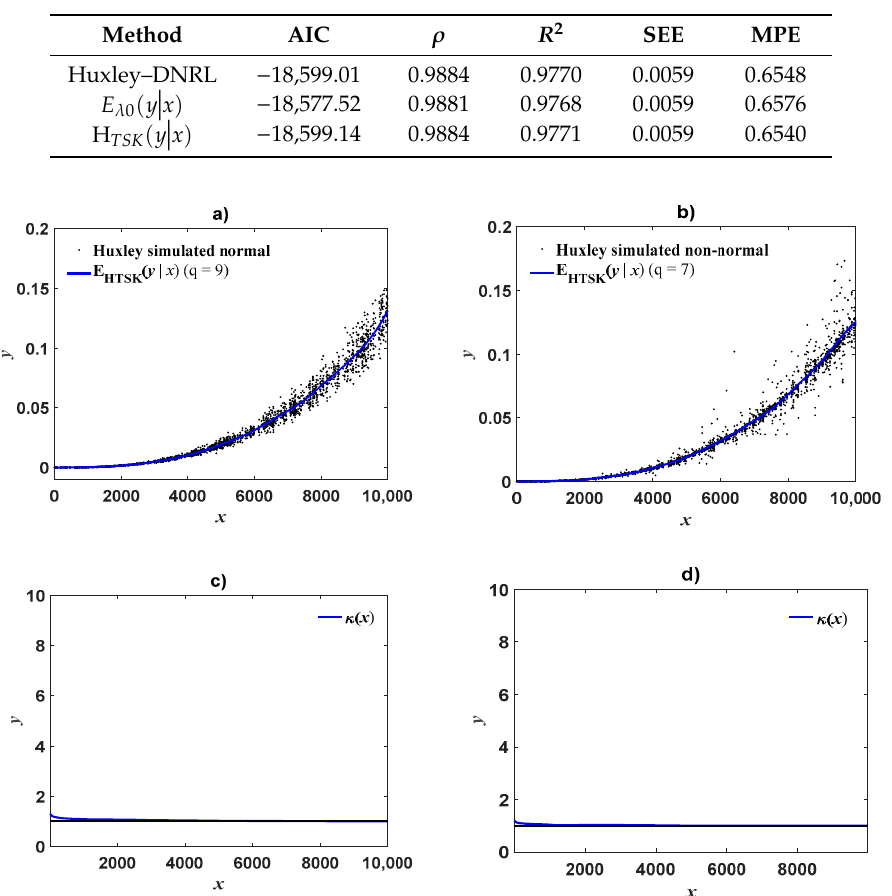
Table E2. Model performance metrics for comparison of proxies by Huxley’s model fitted by DNLR (Huxley-DNR back transformed TAMA (B-TAMA), direct TSK protocol for MCA (DTSK-MCA) identified from data simulated according to non–normally distributed errors ( ξ k ) .